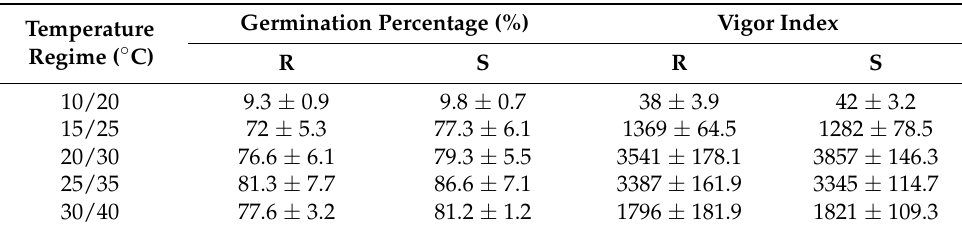
Table 1. Effect of five different temperature regime on seed germination and seedling vigor ( ± SE) of ALS-resistant and ALS-susceptible redroot amaranth